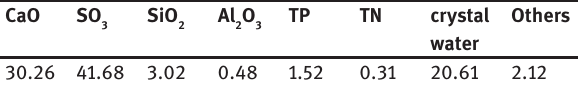
Table 1: The main components of phosphogypsum ( w /%).